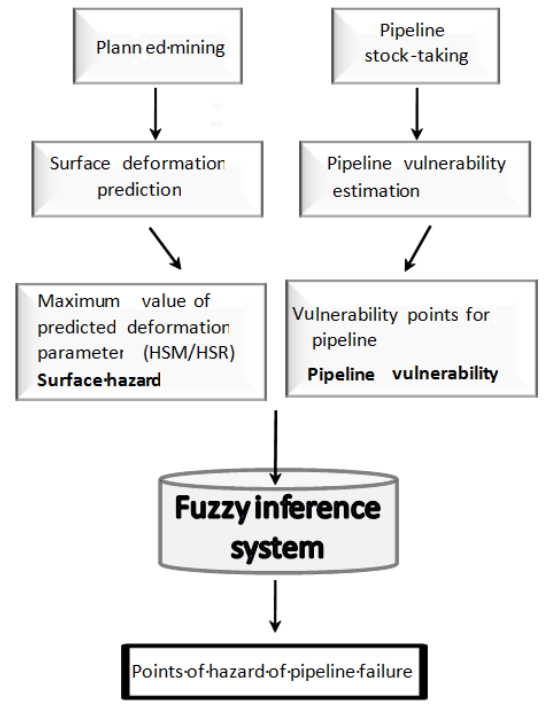
Figure 4. Pipeline damage risk assessment algorithm.